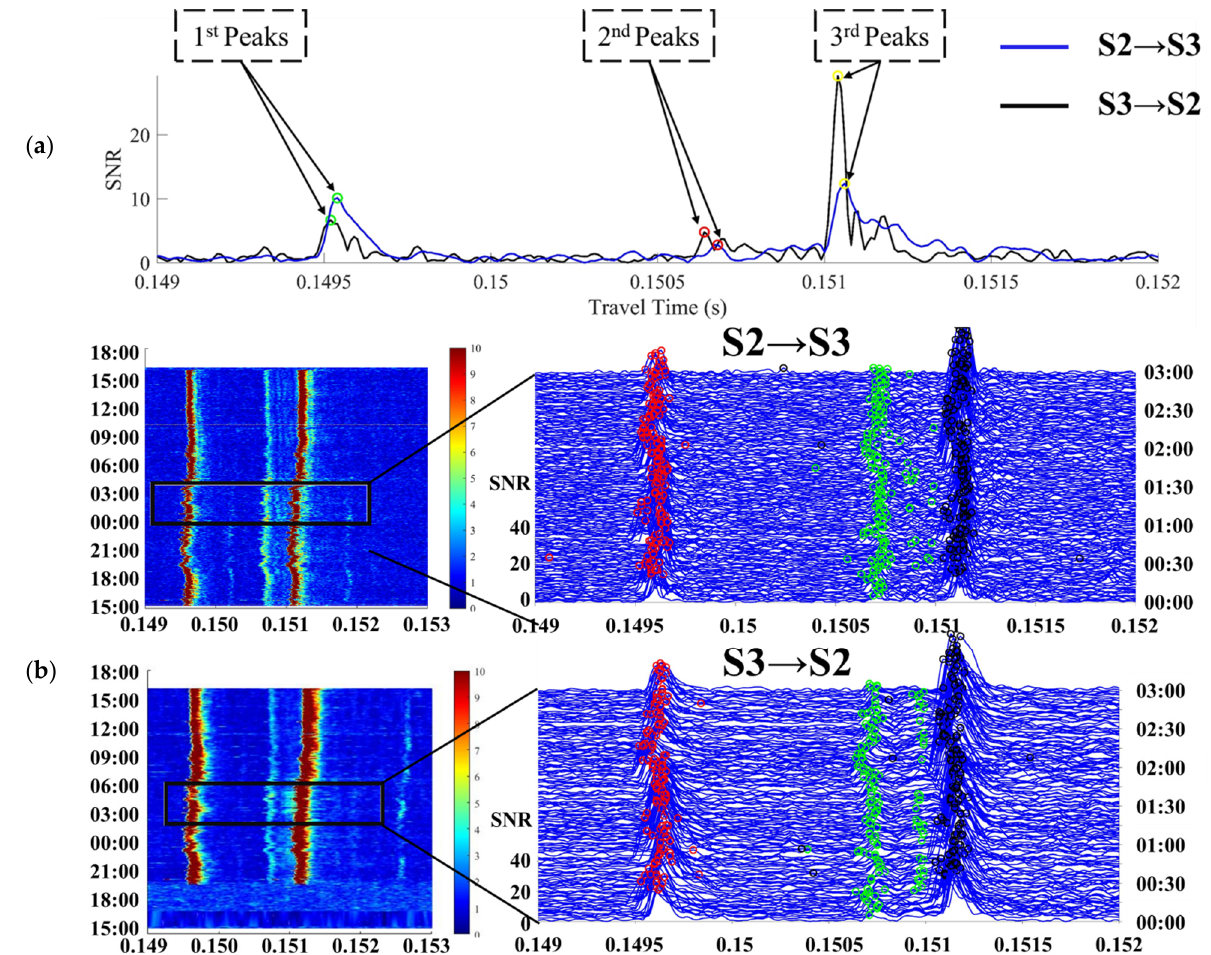
Figure 5. Multi-peak identification. ( a ) A set of cross-correlation results. ( b )The special mooring mode of the CAT Figure 5. Multi ‐ peak identification. ( a ) A set of cross ‐ correlation results. ( b )The special mooring mode of the CAT sta ‐ tion.